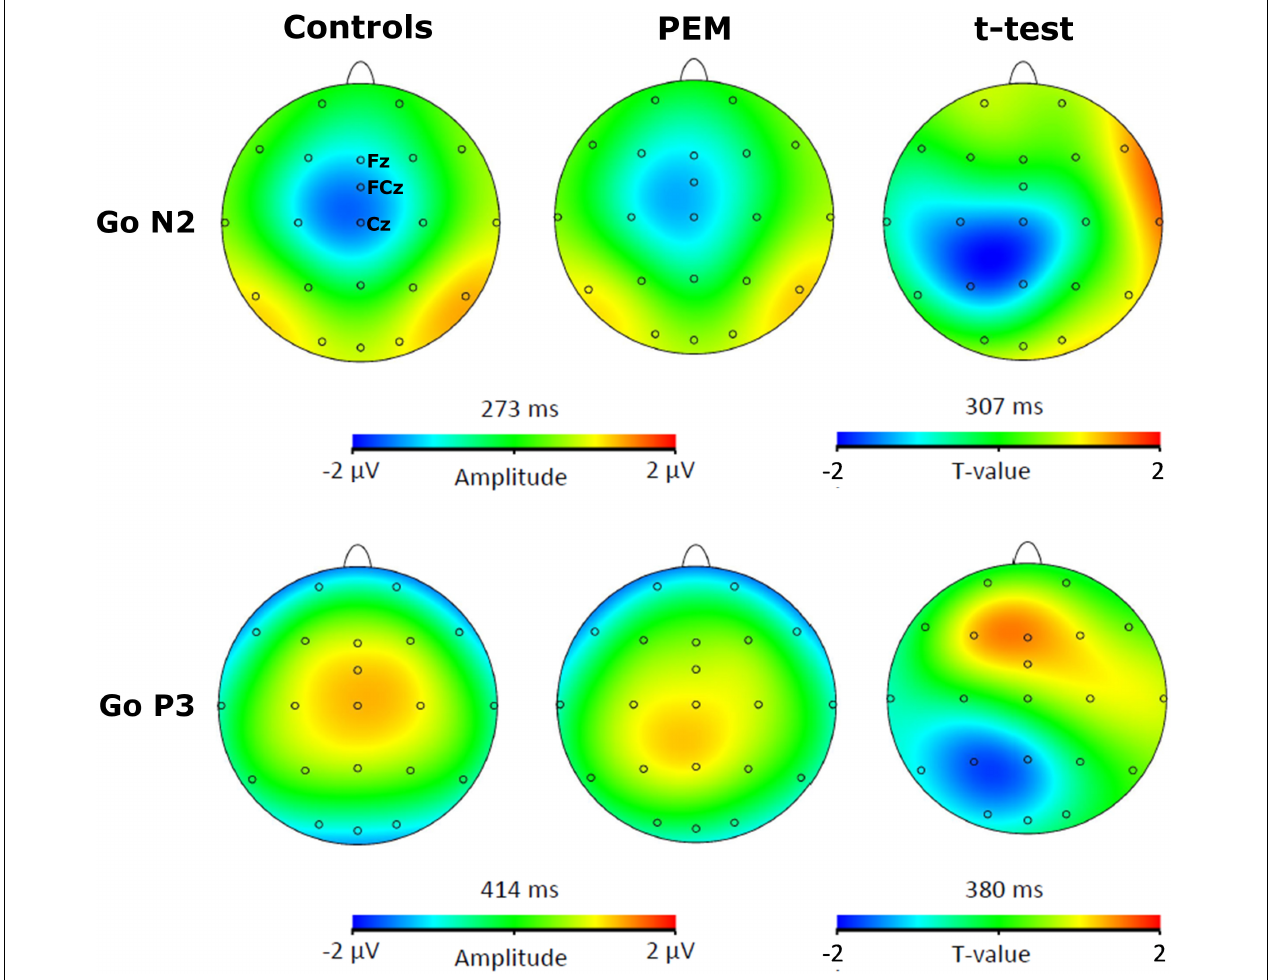
FIGURE 2 | Topographic activation and topographic t -test (not corrected) of the difference of activation between PEM and control groups during Go condition [ t (51) > 2.008, p <